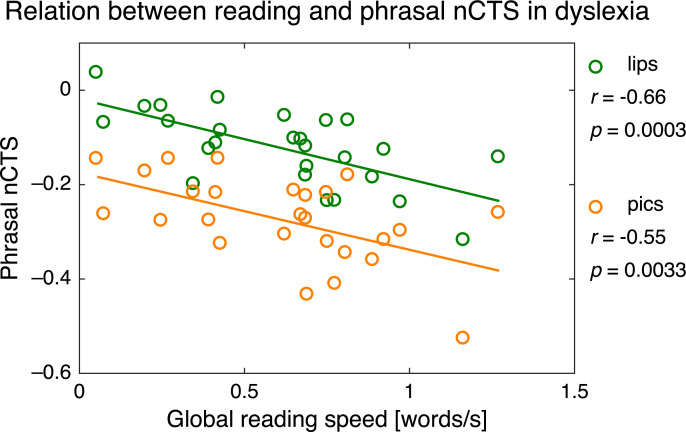
Relation between reading speed and the nCTS at phrasal rate in dyslexia.On the x-axis is the mean of the four reading scores indexing reading speed: reading score for irregular, regular, and pseudowords and Alouette reading speed (converted to a number of words read per second). On the y-axis is the mean nCTS across babble noise conditions and both hemispheres for the two types of visual input: pics (orange) and lips (green). Circles depict participants’ values, and full traces are the regression lines. Correlation and significance level are indicated on the right. S5 Data contains the underlying data for this figure. nCTS, normalized cortical tracking of speech.